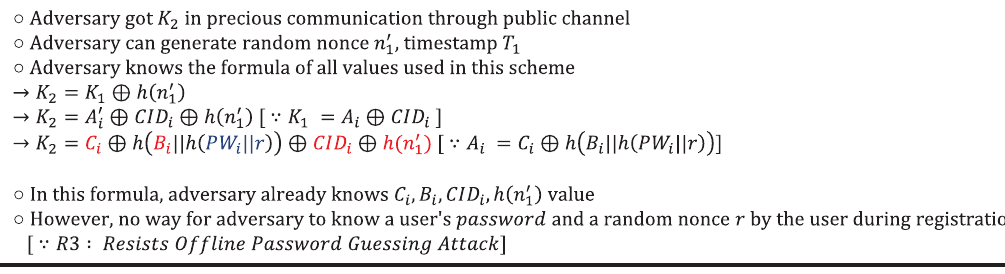
Fig 18. Resistance of proposed scheme to mobile mode impersonation